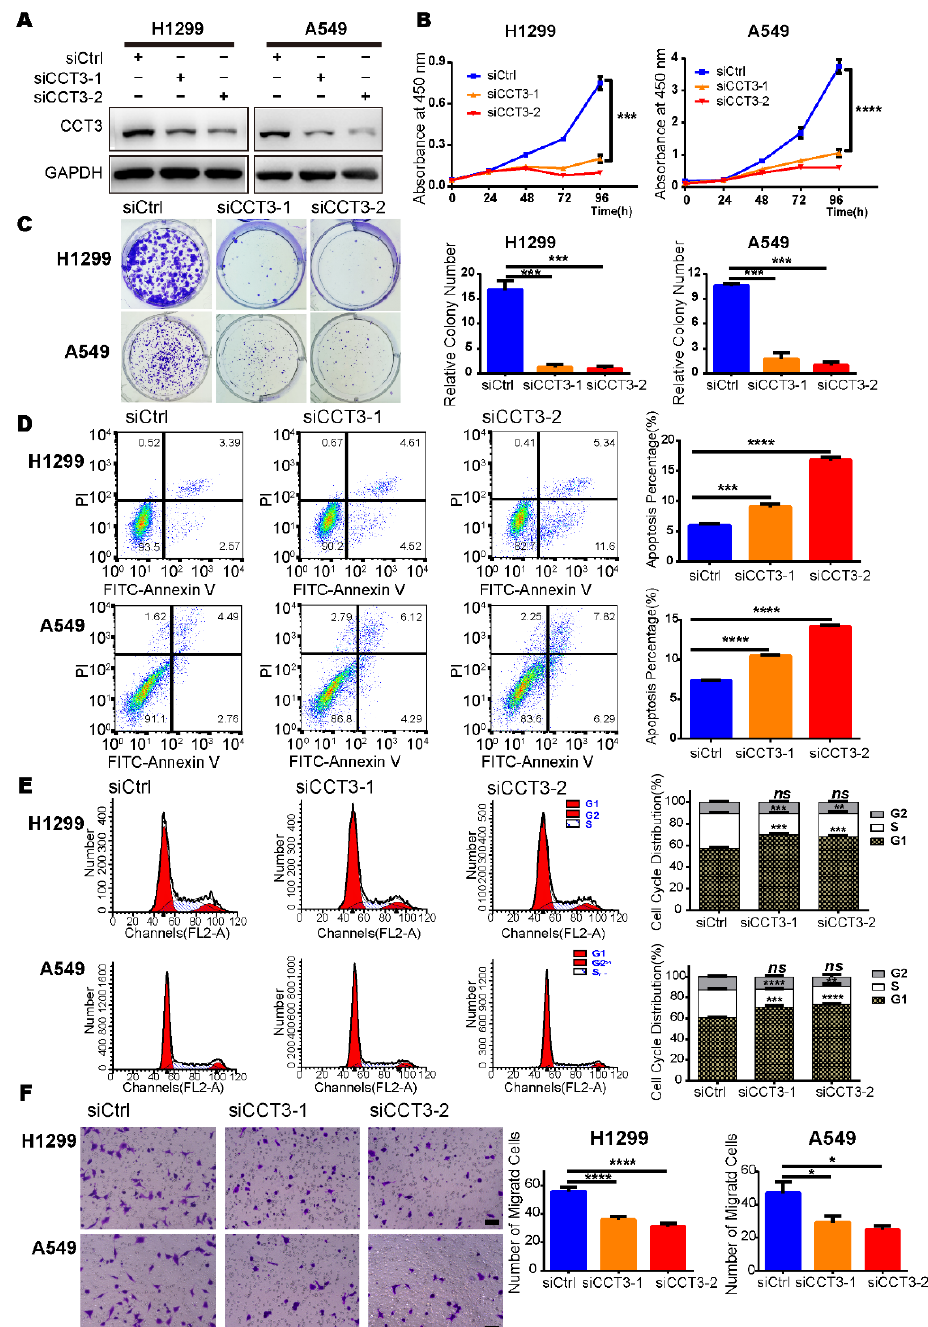
Figure 3. Suppression of CCT3 inhibits the growth and motility of LUAD cells. ( A ) The CCT3 knock- down efficiencies were evaluated by Western blot. ( B ) Cell proliferation (n = 5/group) and ( C ) colony formation (n = 3/group) in CCT3 knockdown cells and corresponding control cells. Representative images of colony formation assays ( left ) and relative colony numbers ( right ). ( D ) Representative images ( left ) and quantitative results ( right ) of apoptosis in LUAD cells treated for 72 h with siRNAs targeting CCT3 or a control. ( E ) Representative images ( left ) and quantitative results ( right ) of cell cycle distribution of LUAD cells after transfection with siRNAs targeting CCT3 or a control for 48 h. ( F ) Representative images ( left ) and quantitative results ( right ) of the transwell assays to evaluate the migration of H1299 and A549 cells with different treatments. At least five fields were quantitated in each well. Scale bar = 100 μ m. Data are shown as mean + SD; ns, not significant; * p < 0.05, ** p < 0.01, *** p < 0.001, **** p < 0.0001, two-tailed Student’s t -test.